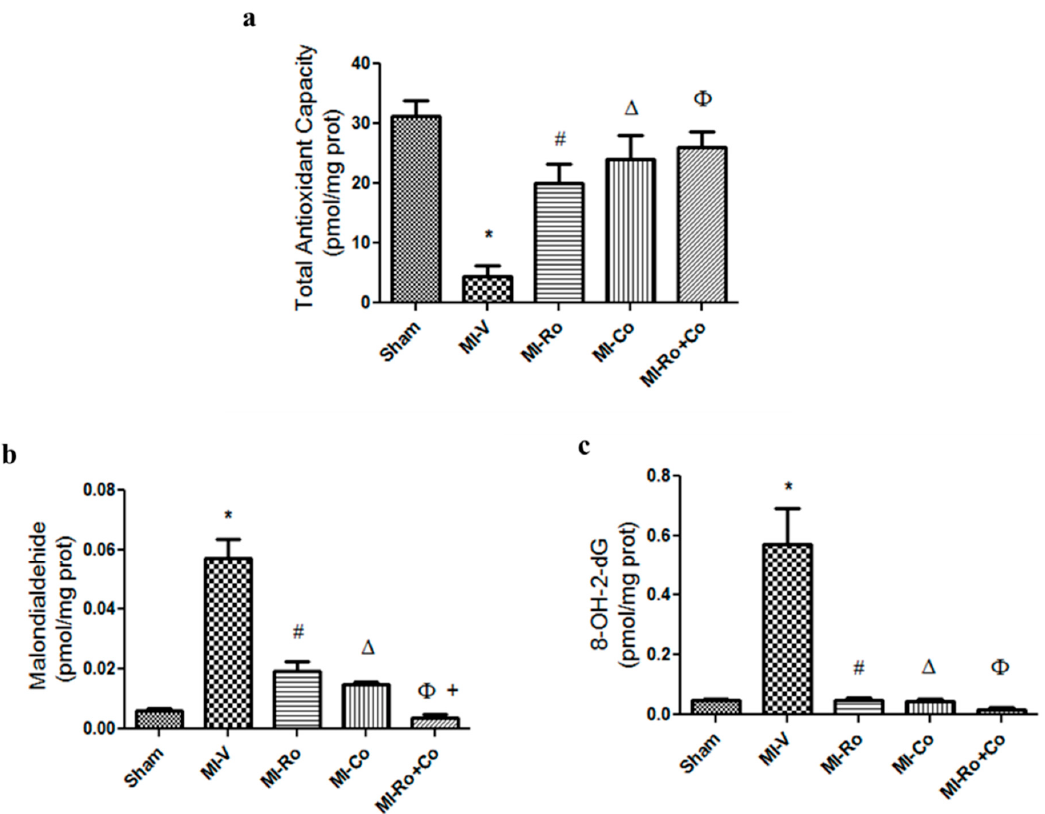
Figure 2. The effect of extracts from Rosmarinus officinalis , Crataegus oxyacantha, and their combination on oxidative stress markers. Total antioxidant capacity (TAC) ( a ); malondialdehyde (MDA) ( b ); and 8-hydroxy-2 ′ -deoxyguanosine (8-OH-2dG) ( c ); The concentrations were evaluated in the ischemic left ventricle areas from rats subjected to sham—or myocardial infarction (MI) and treated seven days with either vehicle (V), Rosmarinus officinalis ( Ro ), Crataegus oxyacantha ( Co ) or their combination ( Ro+Co ). The values show the mean ± SEM from 6 different experiments. p < 0.05 ANOVA one way post Tukey, * Sham vs. MI-V, # MI-V vs. MI- Ro , Δ MI-V vs. MI- Co , Φ MI-V vs. MI- Ro+Co, + MI -Ro vs. MI -Ro+Co.